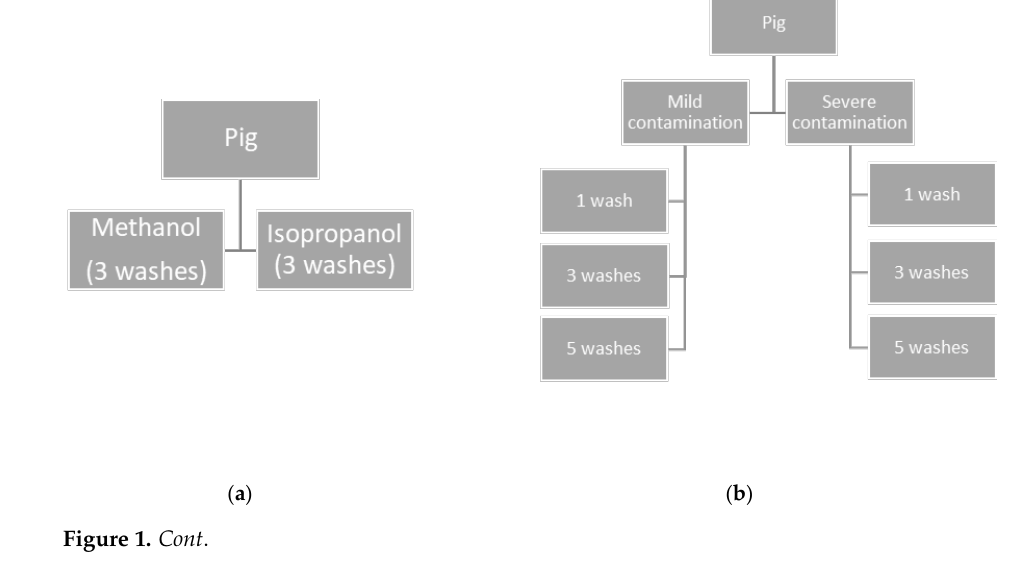
( c ) Figure 1. Experimental design of studies performed. Study 1: the effect of wash solvent on hair and solvent cortisol and DHEA concentrations ( a ); Study 2: the effect of contamination level and wash number on hair and methanol solvent cor- tisol and DHEA concentrations and the solvent-hair ratio ( b , c ). 2.2. Study 2: The Effect of Contamination and Wash Number on Hair and Methanol Wash Solvent Cortisol and DHEA Concentrations, and Their Ratio Using remaining hair from the original 900 mg collected from the same eight grow- finisher pigs as described above, two 300 mg subsamples of hair per pig were used and split into treatment groups: either 25% (mild) or 75% (severe) of the hair surface contami- nated with a mixture of feces and urine. The 300 mg of hair treatment groups were further subdivided into three groups of 100 mg, receiving one, three, or five methanol decontam- ination washes (Figure 1b). Thus, each individual pig served as its own control, with six different treatments (mild contamination with one wash, mild contamination with three washes, mild contamination with five washes, severe contamination with one wash, se- vere contamination with three washes, and severe contamination with five washes). No